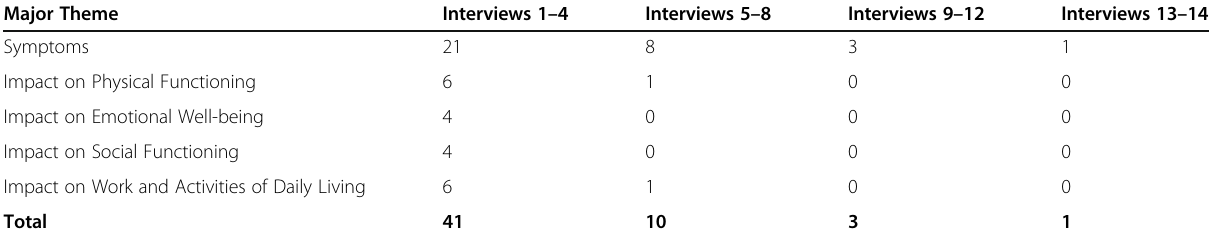
Table 1 Saturation analysis: number of new concepts identified per interview set across each major theme Major